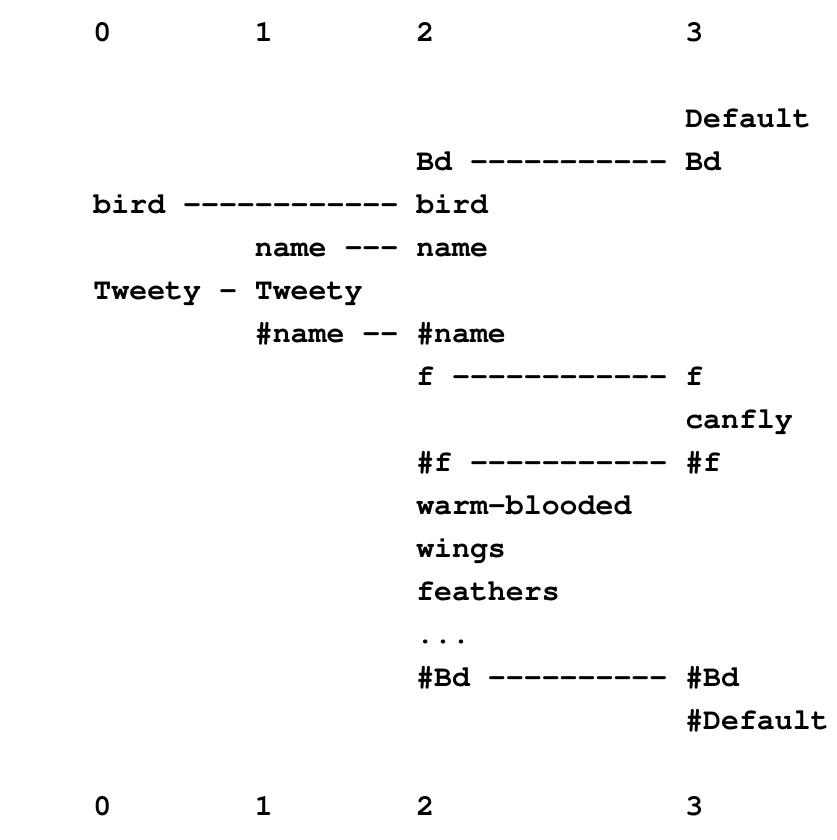
Figure 17. The first of the three best multiple alignments formed by the SP model with “ bird Tweety ” in New and patterns in Old, as described in the text. The relative probability of this multiple alignment is